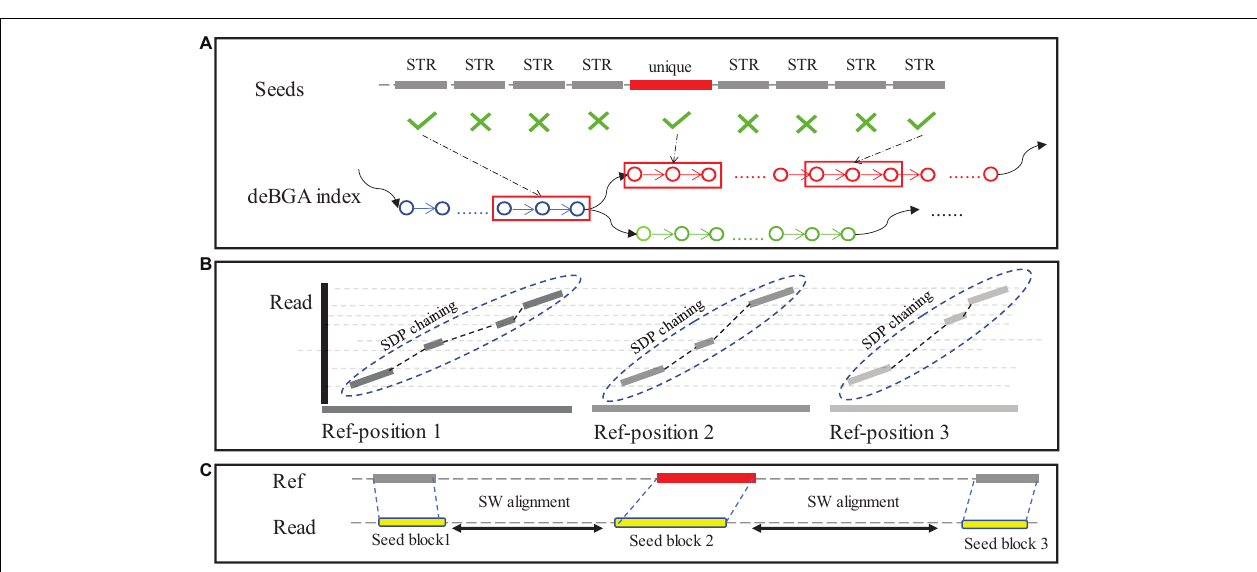
FIGURE 1 | Overview of PanSVR SV calling process. Three main steps of PanSVR SV calling process. (A) In the first step, SV reference is built from known SVs; (B) In the second step, read signals are extracted from original BAM files and mapped to the SV reference; (C) Finally, read signals clustered around SV breakpoints are assembled and SV results generated from consensus strings.